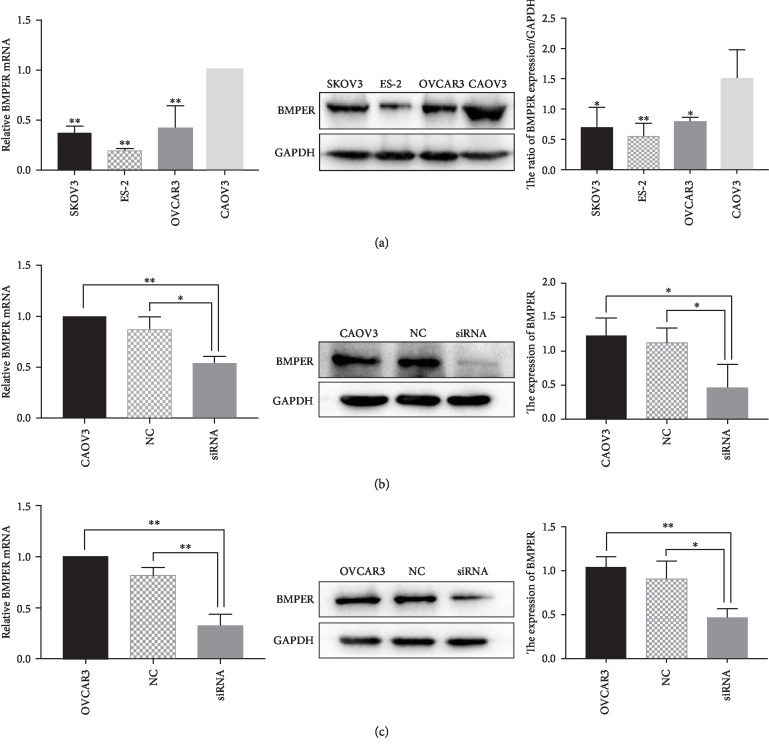
The expression of BMPER in ovarian cancer cell lines. (a) The levels of BMPER mRNA and protein in four ovarian cancer cell lines were detected by real-time PCR and Western blot. ∗P < 0.05, ∗∗P < 0.01. (b–c) The expression of BMPER mRNA and protein in ovarian cancer cell lines CAOV3 and OVCAR3 after BMPER siRNA transfection for 72 hours by real-time PCR and Western blot. The asterisks indicate significant differences, ∗P < 0.05, ∗∗P < 0.01.